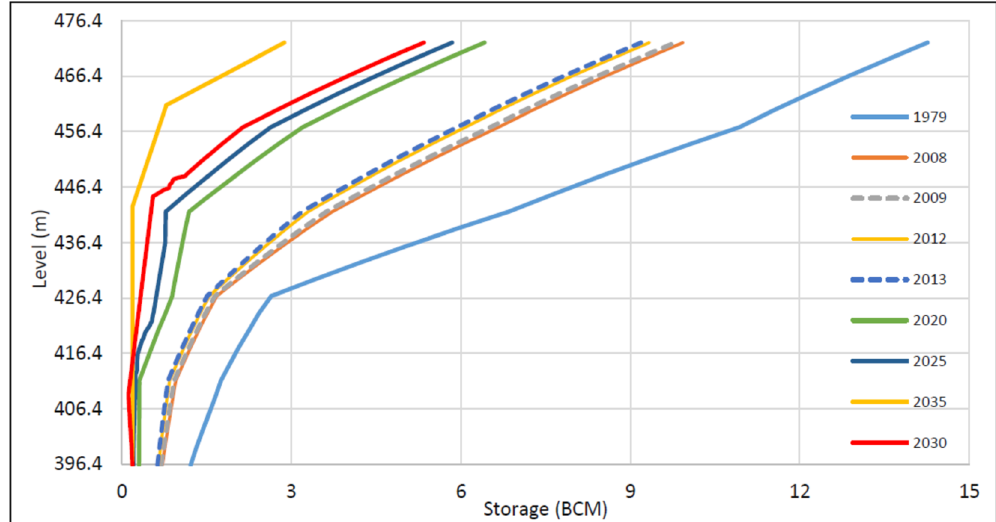
Figure 12. Tarbela Reservoir storage capacities.